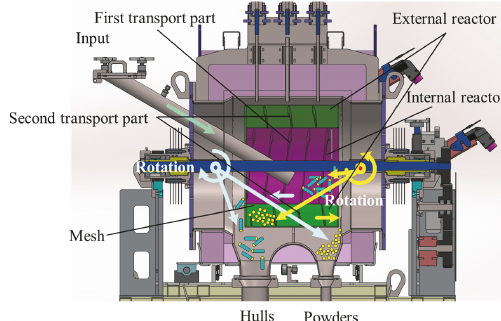
Figure 4: Separation of hulls and powder using the screw-and- rotation method.